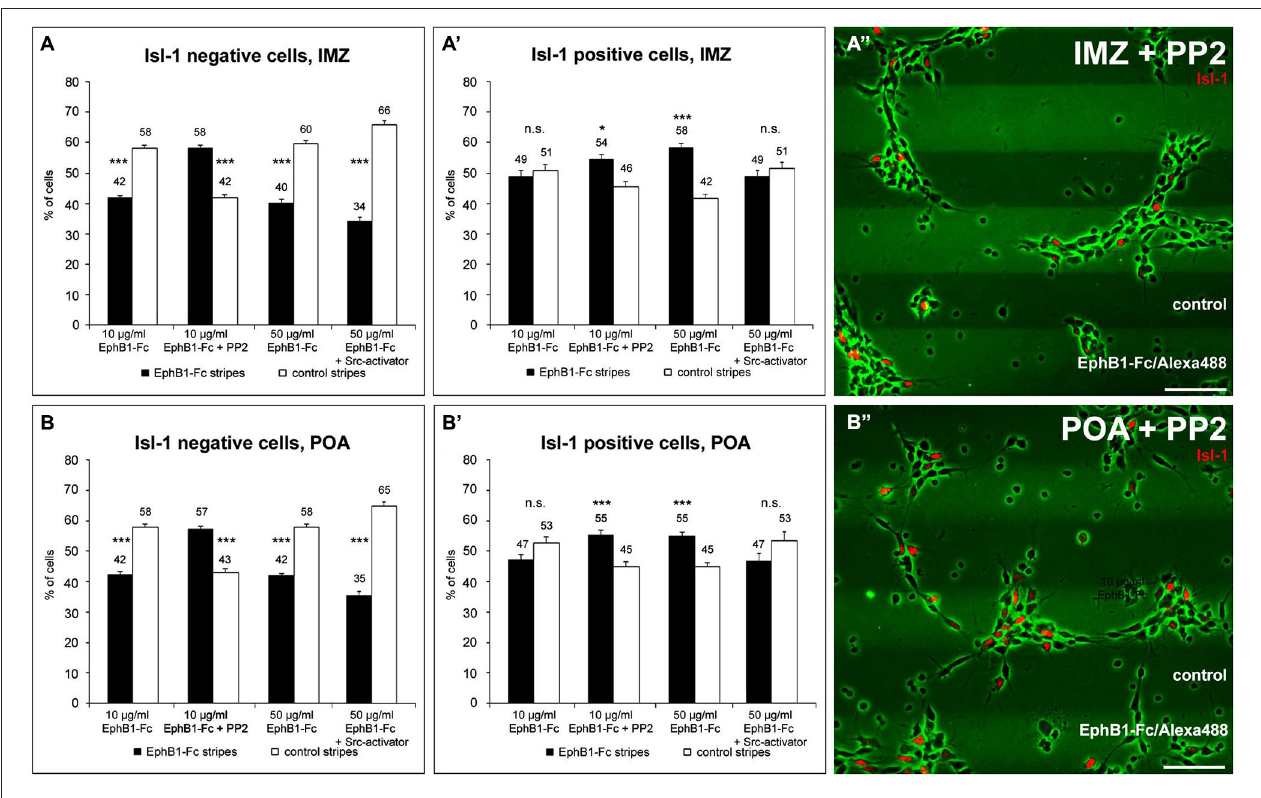
EphB1-Fc and control stripes containing 10 µ g/ml EphB1-Fc (left, middle left) or 50 µ g/ml EphB1-Fc (middle right, right). In some experiments 5 µ M PP2 (middle left in A–B’; A”–B” ) or 5 µ M Src-activator (right in A–B’ ) were added. Student’s t -test * p < 0.05; ** p < 0.01; *** p < 0.001. Scale bars: 50 µ